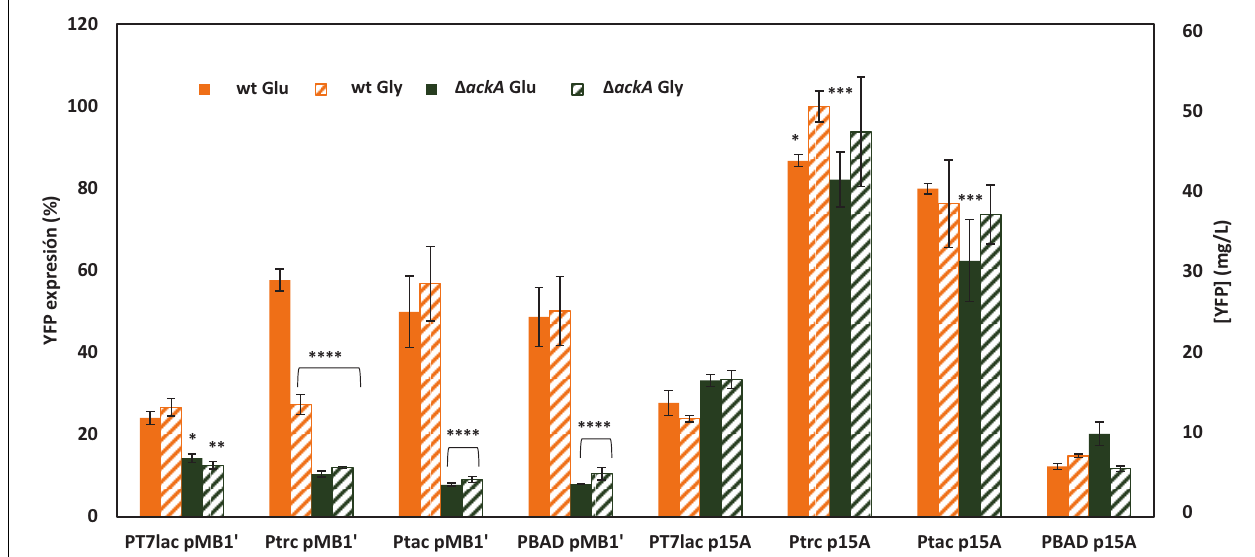
FIGURE 4 | YFP expression of E. coli wt or deficient ackA mutant growing with glucose or glycerol as carbon sources carrying different expression system vectors. Expression is shown as a percentage with respect to expression of E. coli wt transformed with the plasmid pSF-p15A-trc-YFP growing with glycerol as the 100%. Secondary y-axis shows YFP concentration (mg/L). Expression of E. coli wt is shown in orange and E. coli (cid:49) ackA in green. Glucose cultures are in solid bars, while glycerol supplemented cultures are shown in striped bars.